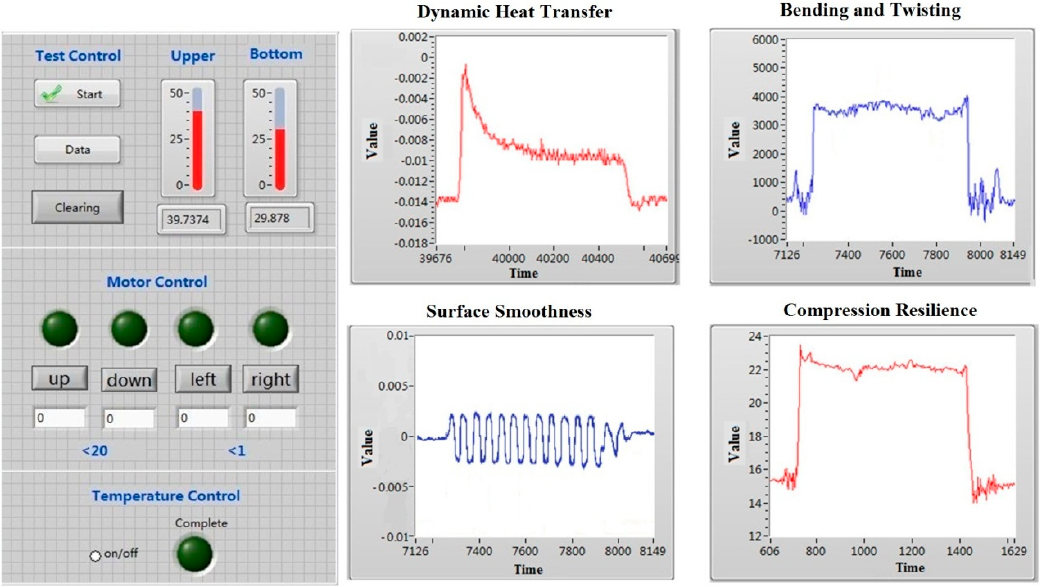
Figure 5. Front panel interface of the virtual instrument system.